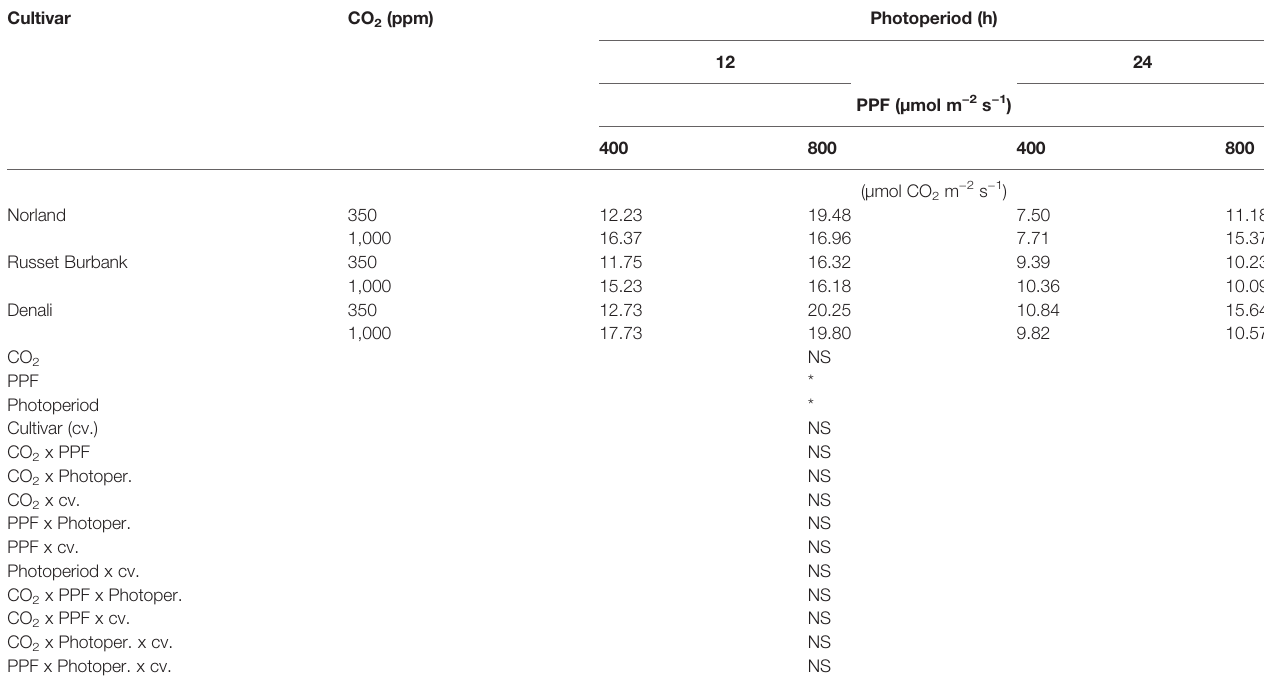
TABLE 2 | Net photosynthetic rates of potatoes under different photoperiods, CO 2 , and photosynthetic photon fl ux levels (70 days after planting). Cultivar